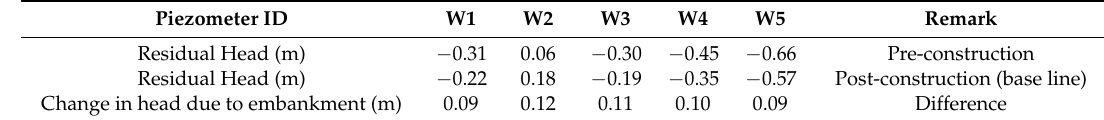
Table 3. Change in head across the piezometers due to the embankment (pre and post-construction).